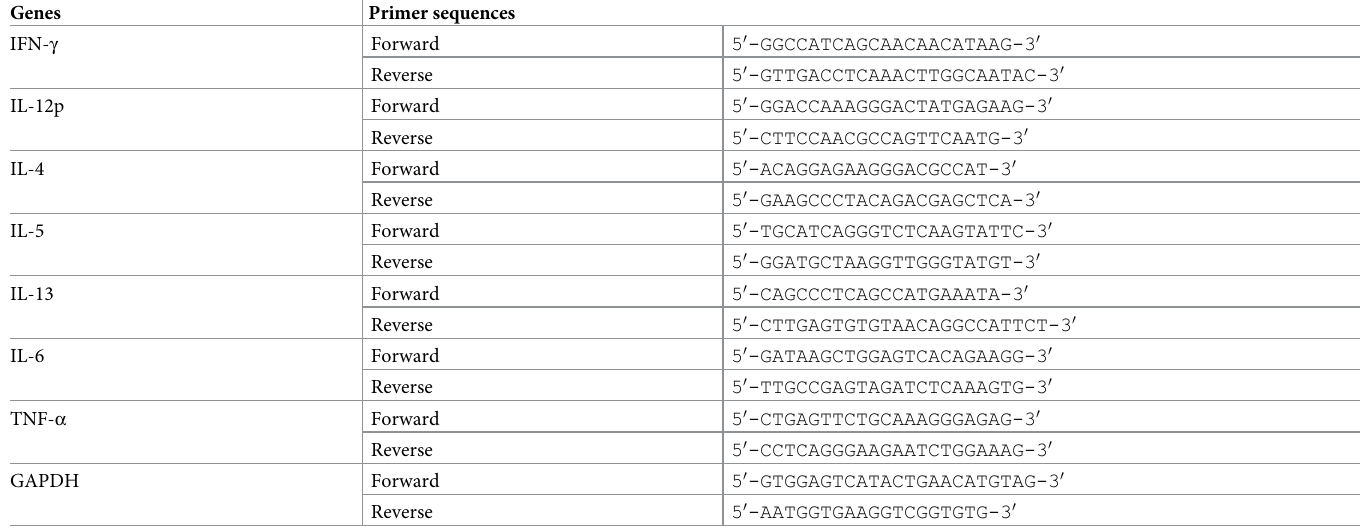
Table 1. Primer sequences for